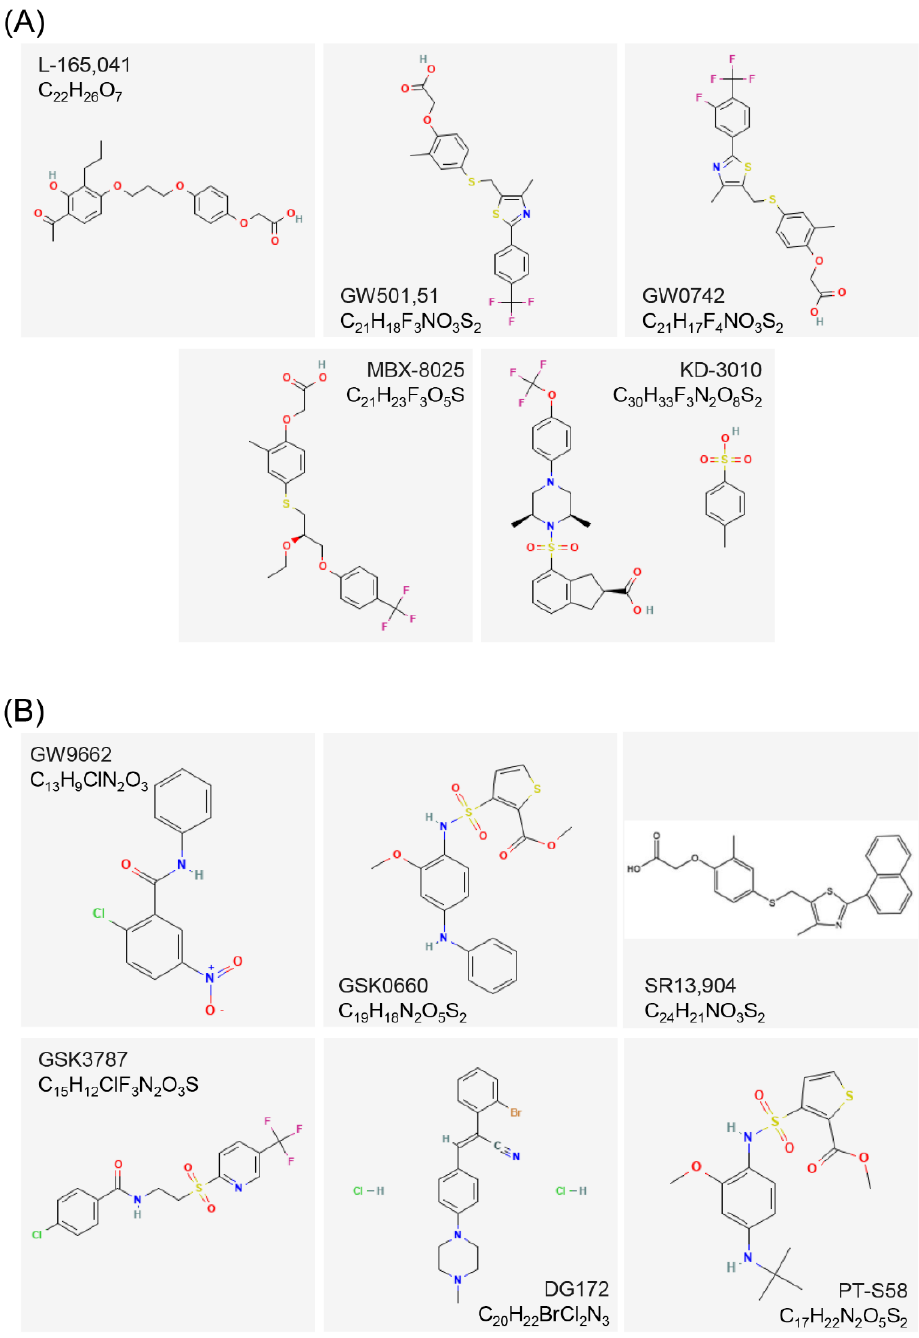
Figure 4. Agonist ( A ) and antagonist ( B ) secondary structures of PPARβ/δ .